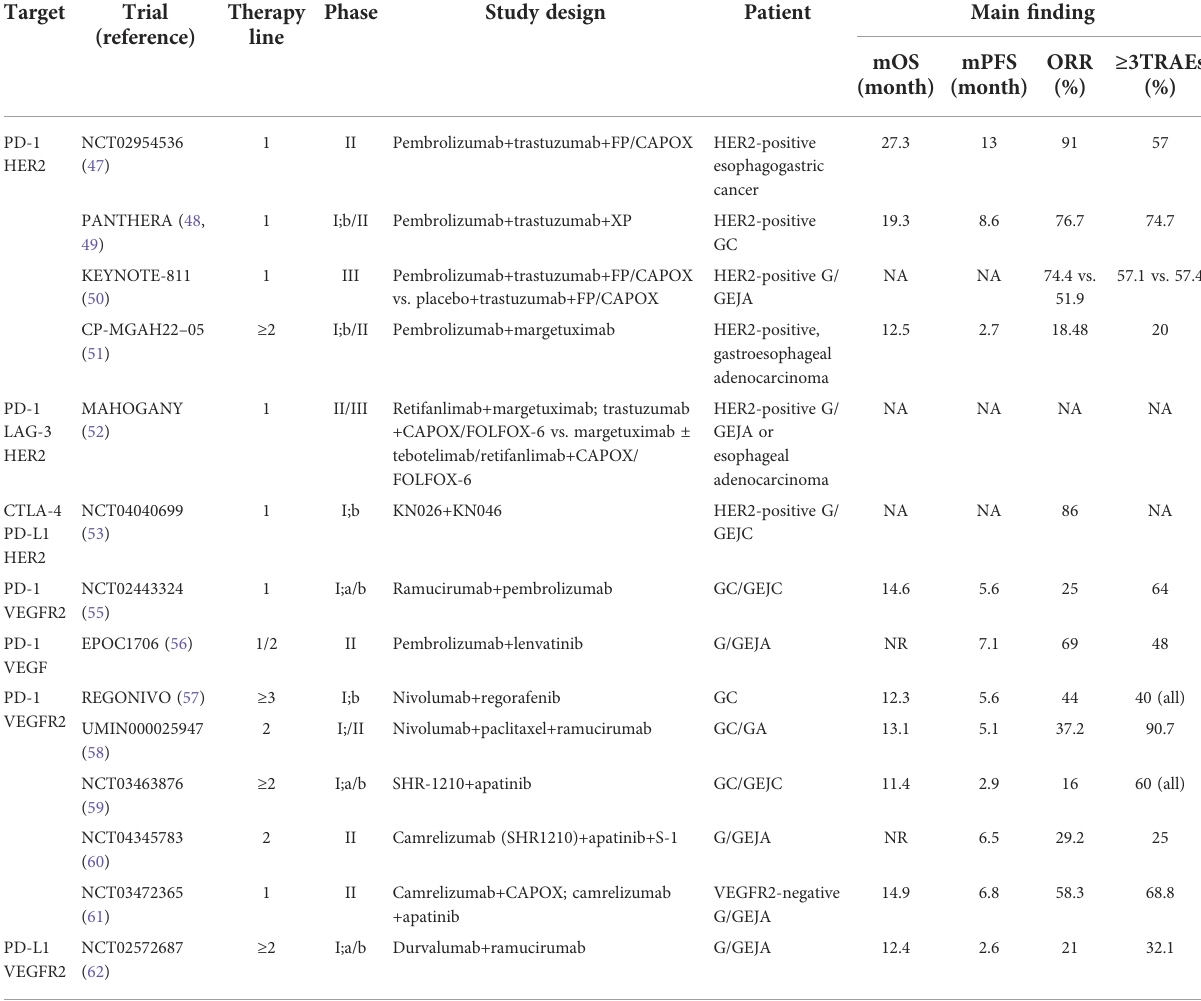
TABLE 3 Clinical trials of immune checkpoint inhibitors combined with targeted therapy for advanced gastric cancer. Target Trial Therapy Phase Study design (reference) line